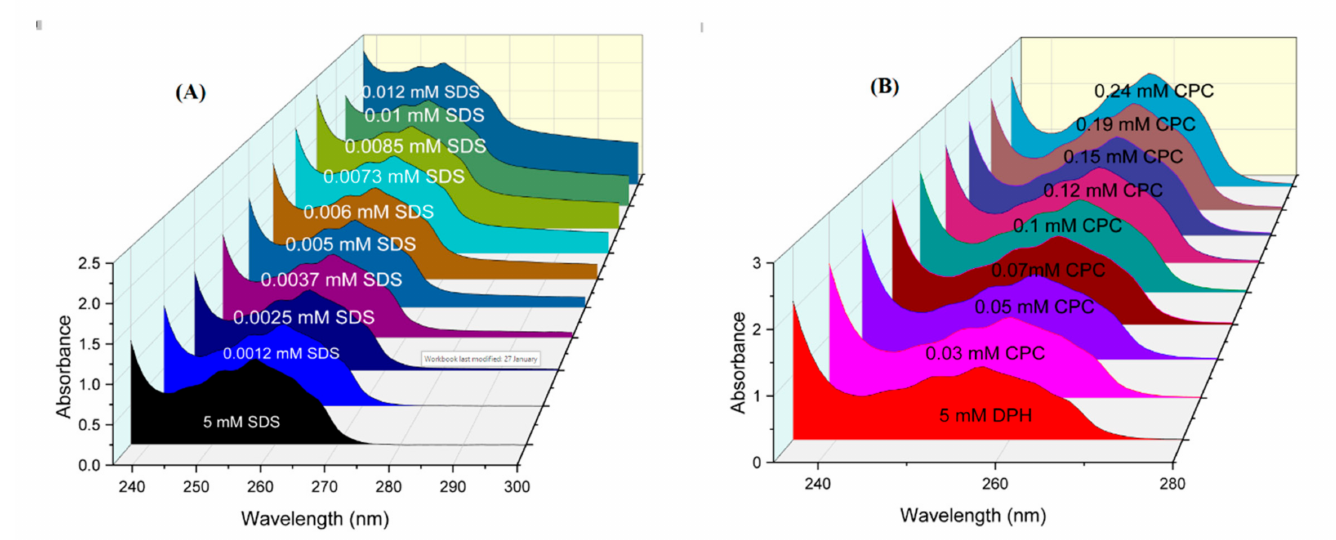
Figure 3. Adsorption spectra of DPH with increasing concentration of ( A ) SDS, ( B )